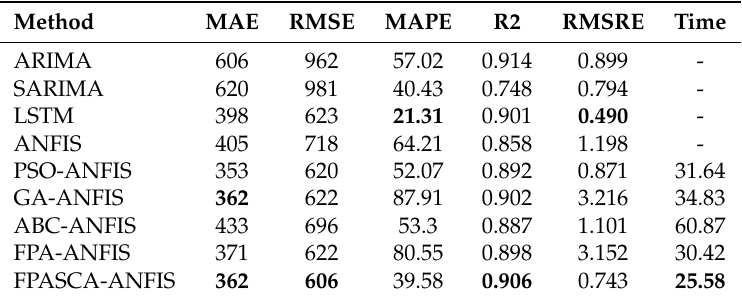
Table 2. Computational results of